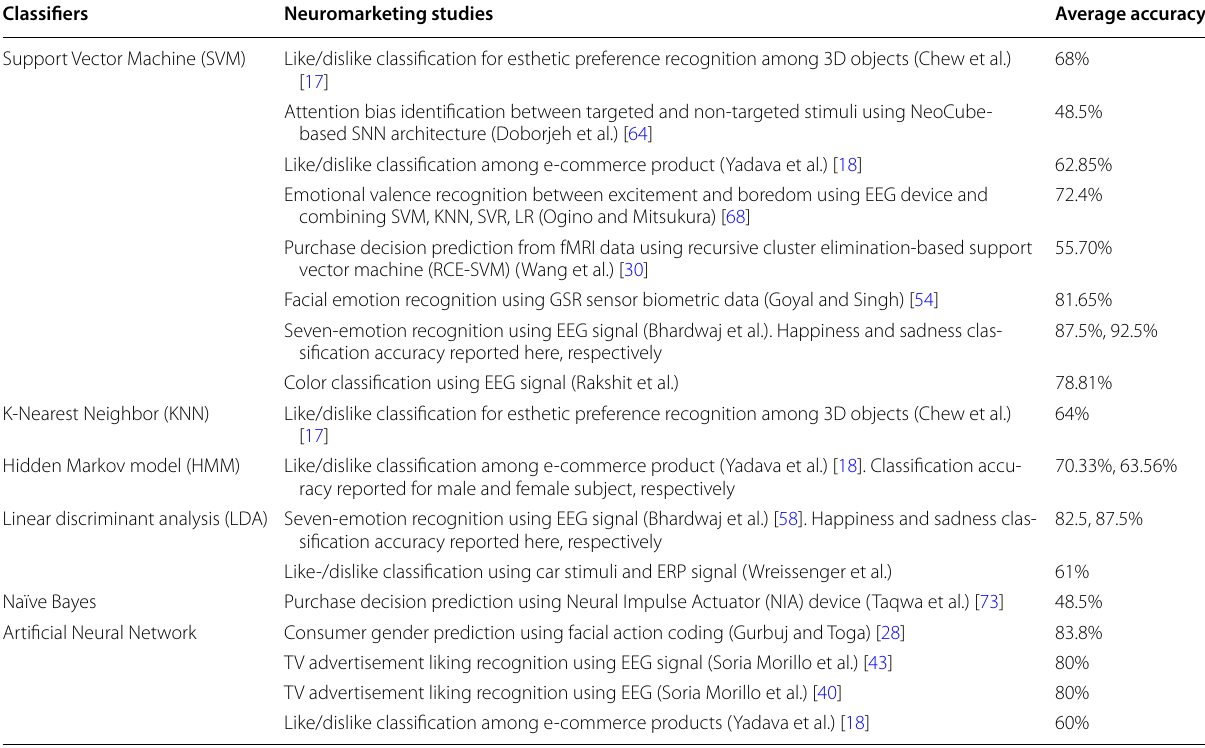
Table 4 Comparative accuracy analysis for machine learning classifiers in Neuromarketing